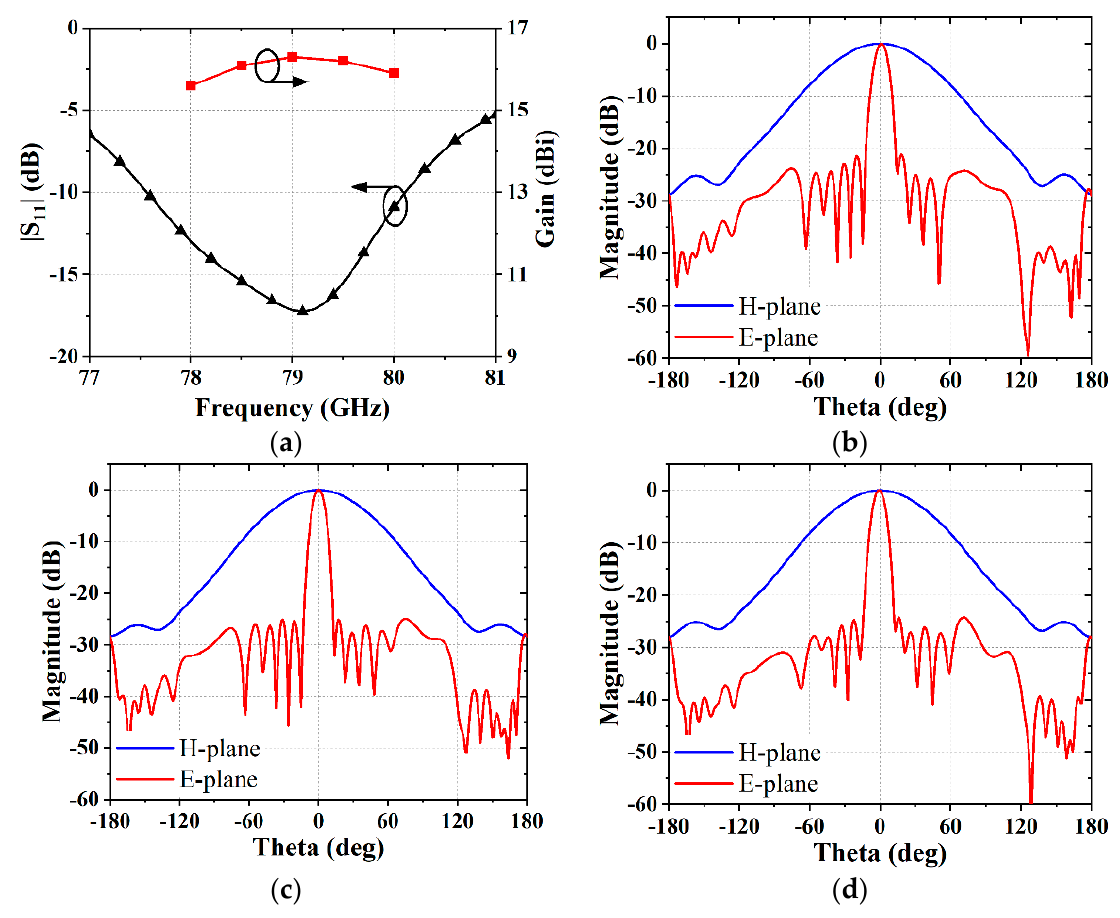
Figure 3. Simulated results of the series − fed patch array. ( a ) Reflection coefficient and gain. ( b ) Pattern at 78 GHz. ( c ) Pattern at 79 GHz. ( d ) Pattern at 80 GHz.